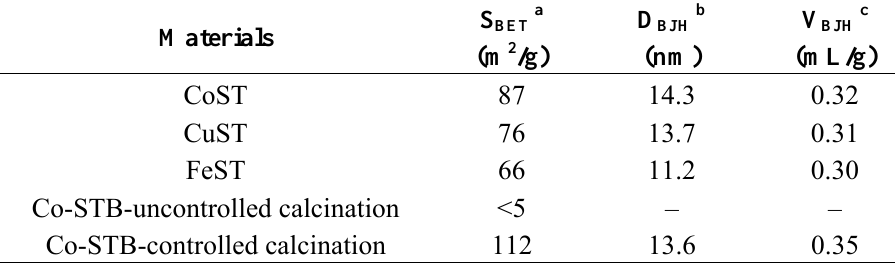
Table 1. Textural properties of the synthesized